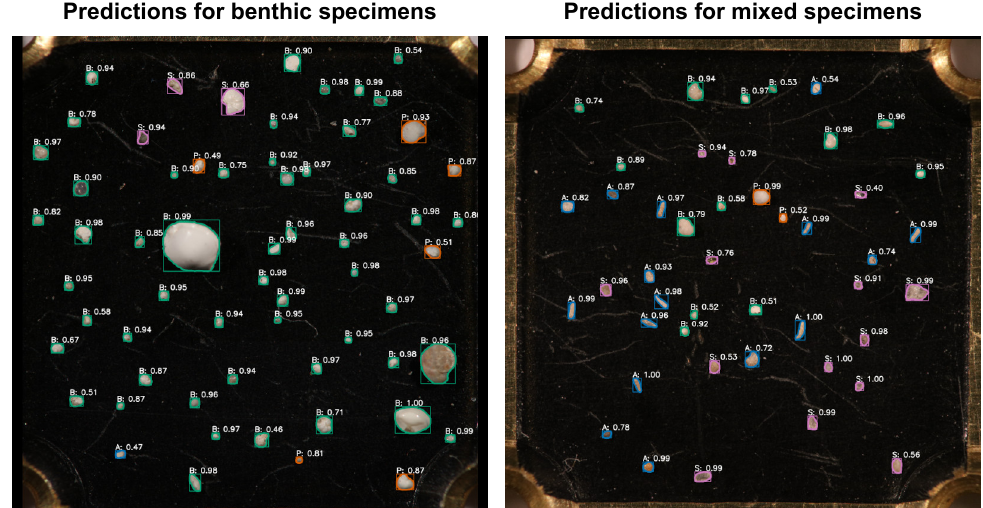
Figure 11. Examples of predictions for two images from the test dataset. ( Left ): Predictions for purely calcareous benthic specimens. The accuracy and quality of the predicted masks and bounding boxes are good, but there are several misclassified objects. ( Right ): Predictions for a mixture of specimen types. The accuracy and quality of the predicted masks and bounding boxes are good. However, there are misclassified detections for this image, as well.